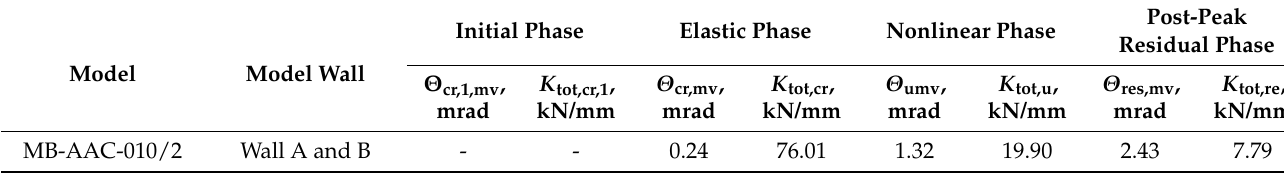
Table 5. Stiffness of stiffening walls based on the test.